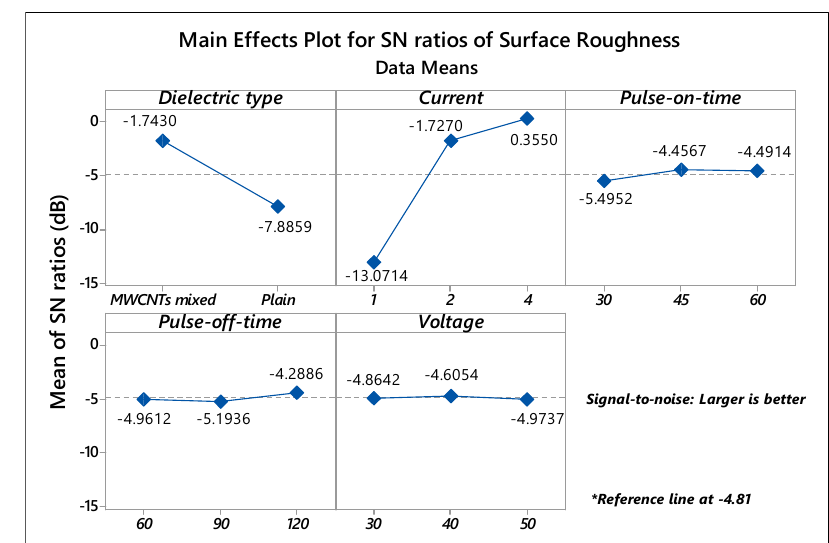
Figure 3. Main effects SN ratios plot of Surface Roughness. Figure 3. Main e ff ects SN ratios plot of Surface